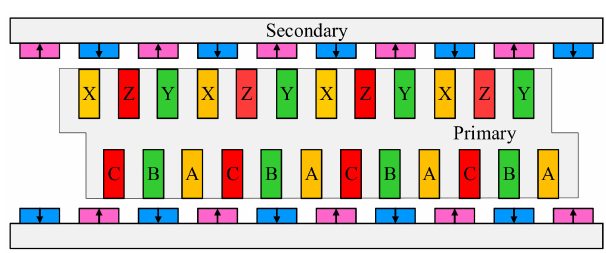
Figure 14. Model I.